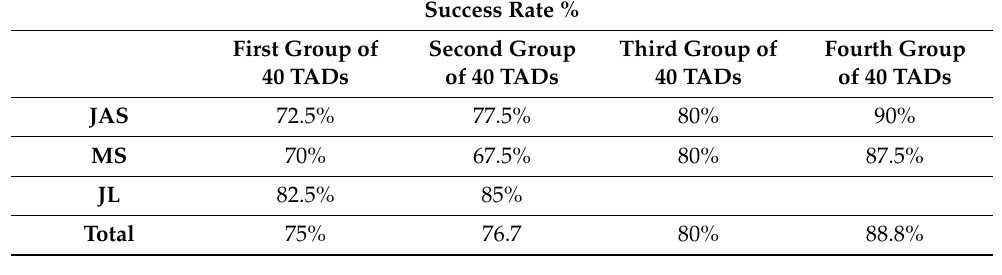
Table 1. Success rate of TAD insertions (according to groups of 40 TADs) for each doctor separately and in total.